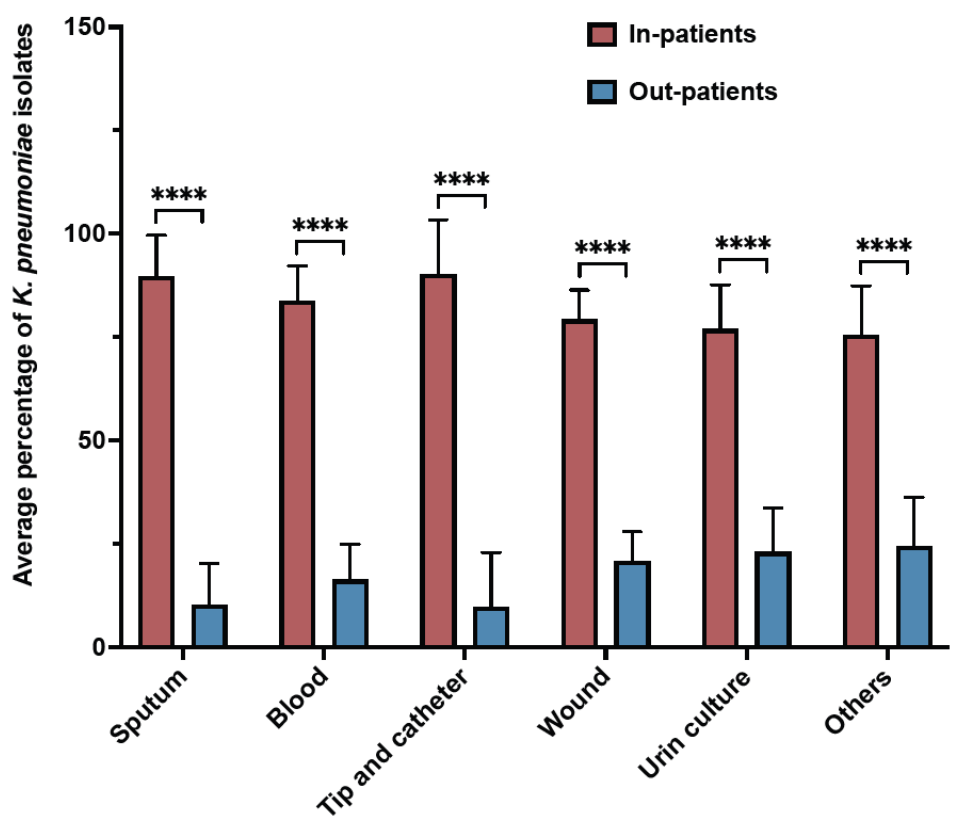
Figure 3. Samples distribution of K. pneumoniae isolates from inpatients and outpatients over 11 years. **** p ≤ 0.000001.